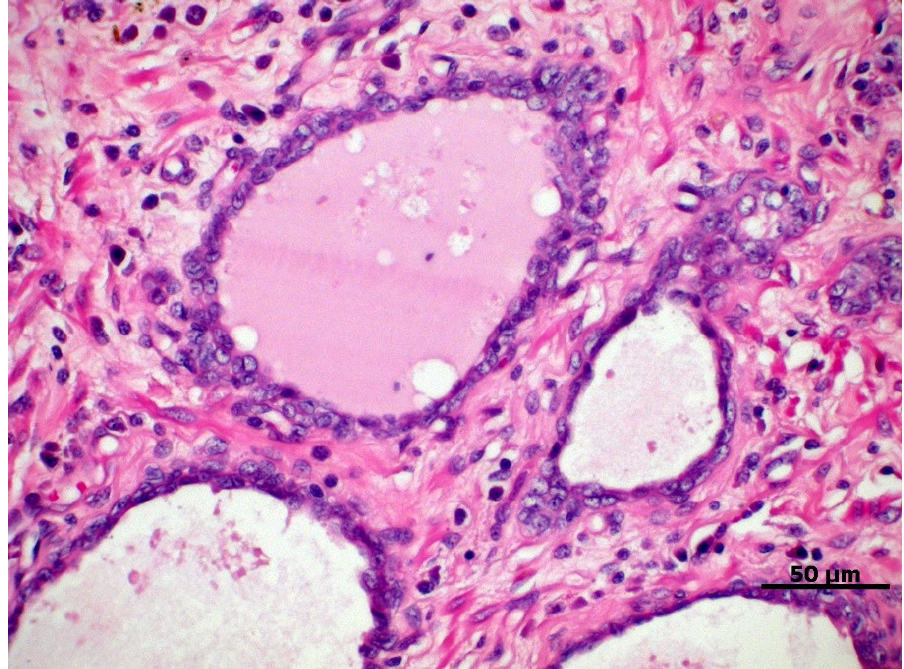
Figure 1. Proliferative inflammatory atrophy in canine prostate, characterized by discrete prolifera- tion of prostatic epithelium associated with mononuclear inflammatory infiltrate in the glandular interstitium. HE, 40×.